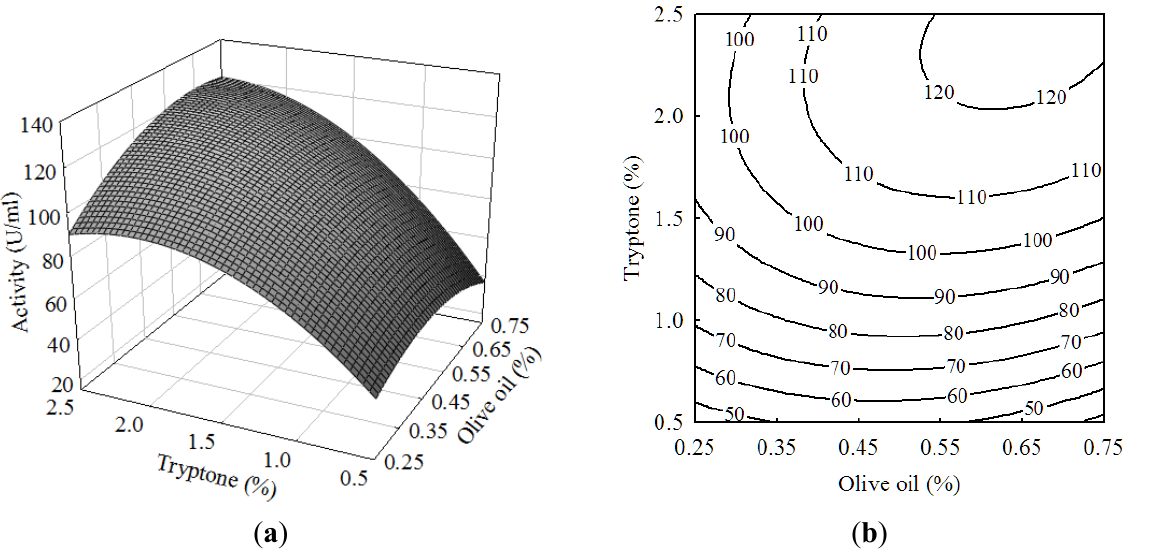
and tryptone on the lipase activity of Burkholderia sp. HL-10.